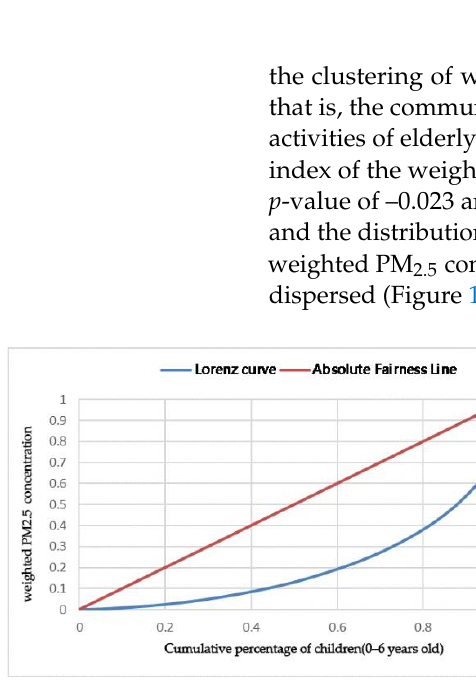
Figure 8. Community PM 2.5 pollution exposure risk classification results .